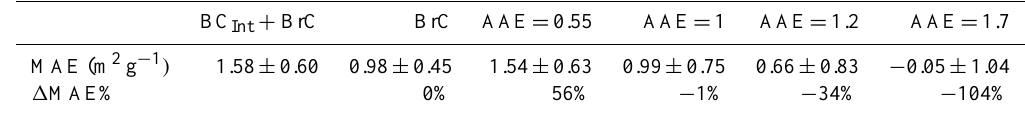
Table 1. Measured and modelled mass absorption efficiencies (404nm), and calculated differences. BC Int + BrC BrC AAE =